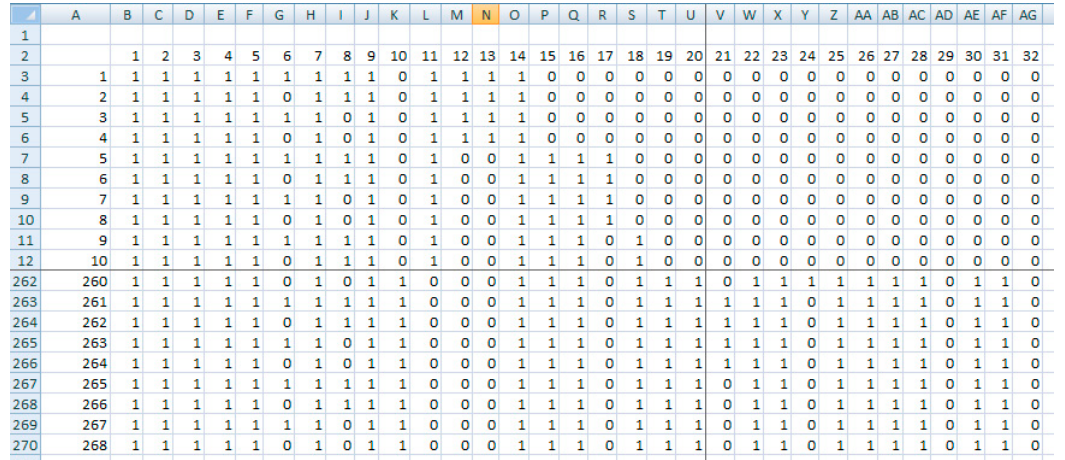
Figure 5. Part of the 32 × 268-dimension binary matrix of the implementation of the FLR algorithm.